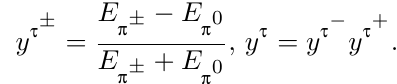
via an intermediate r 0 to three charged 1